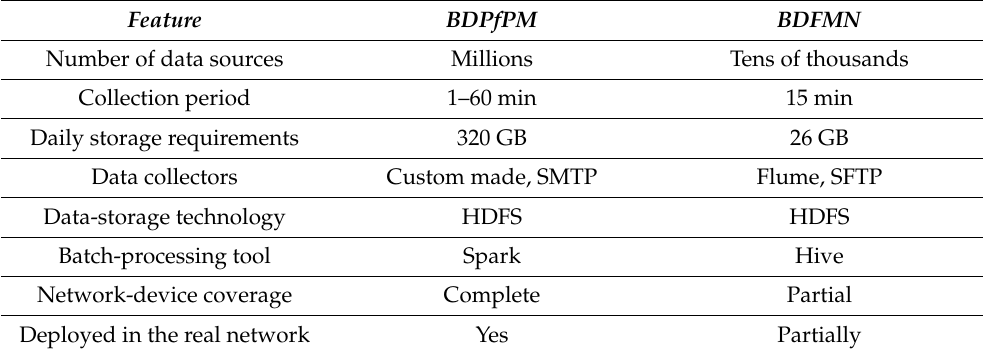
Table 3. BDPfPM and BDFMN